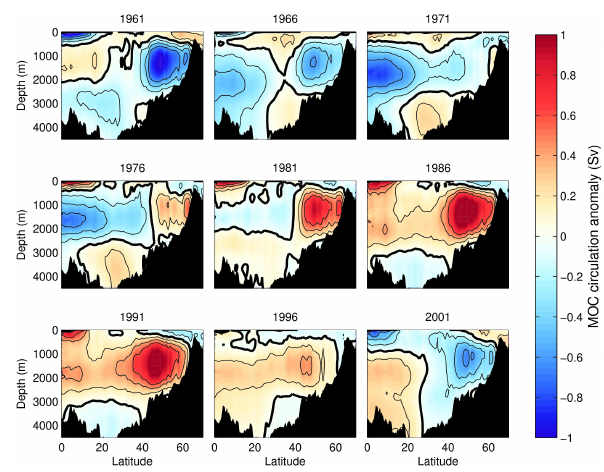
Figure 11. Circulation anomaly of the MOC stream function (Sv). Positive anomalies (red) are clockwise and negative anomalies (blue) are anticlockwise.